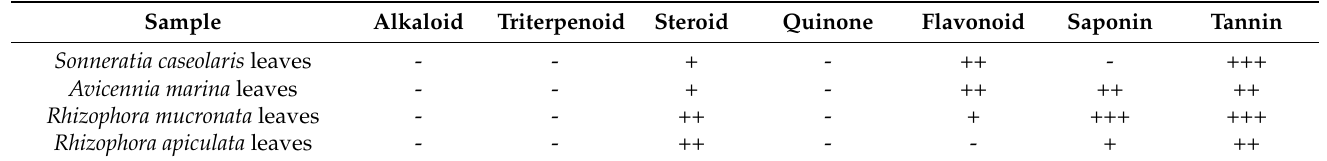
Table 1. Phytochemical screening for dried simplicial leaves of various local mangrove species leaves, as performed by Audah et al. [16] as a preliminary study.